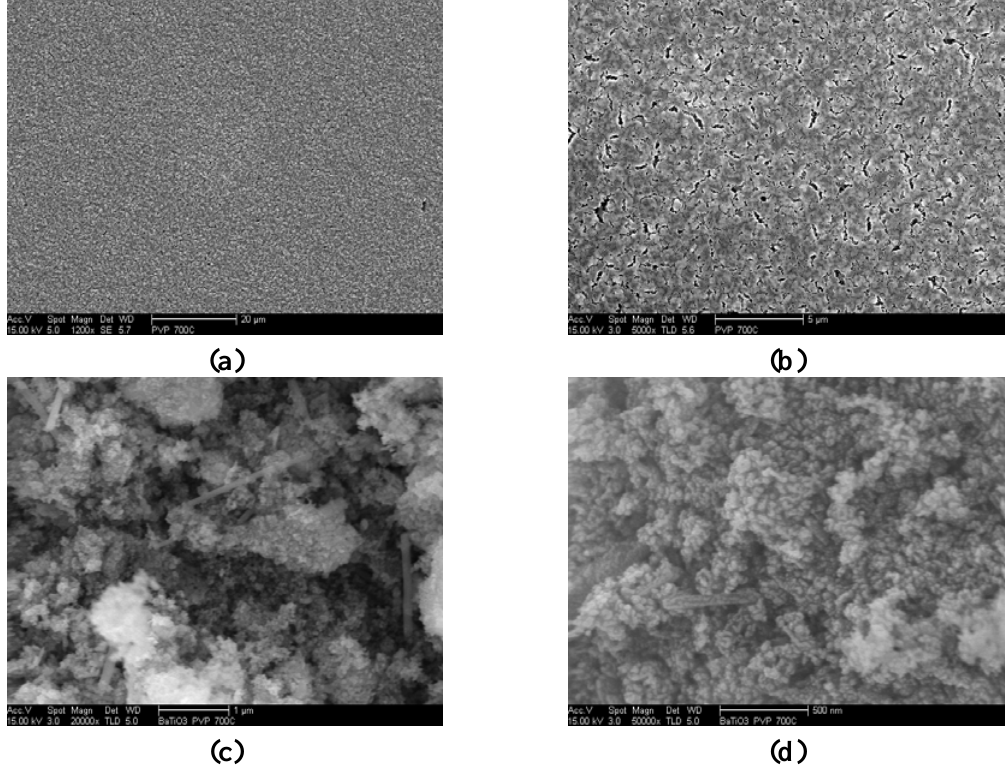
Figure 7. Cross section SEM micrograph of BaTiO